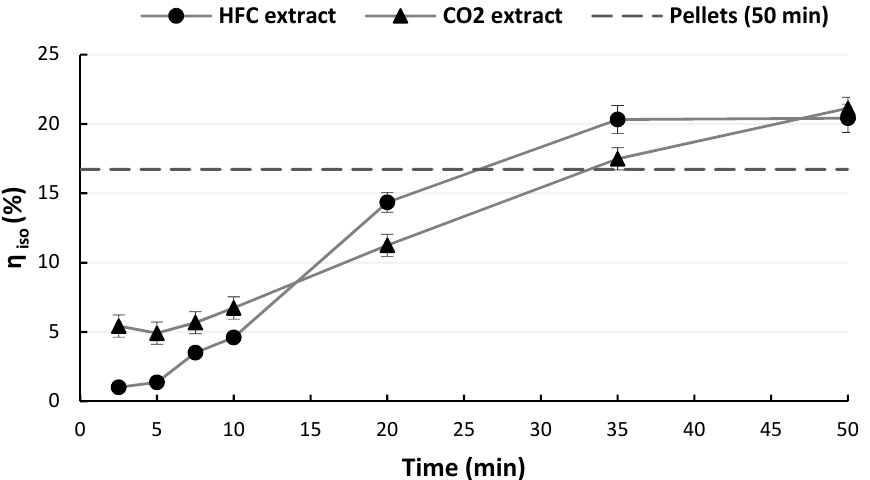
Figure 5. Isomerization yield, η iso, referred to the total α -acid amount added to the wort by means of CO 2 and HFC extracts, at the beginning of the lab-scale isomerization trials. Horizontal line indicates the isomerization percentage reached after 50 min boiling by pellet addition.